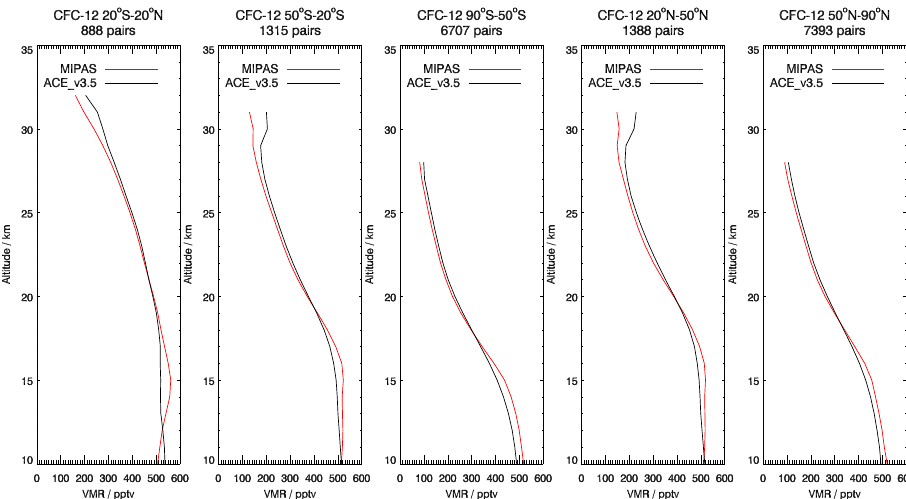
Figure A4. Comparison of mean profiles of MIPAS CFC-12 (red line) and ACE-FTS (black line) for different latitude bins for the years of